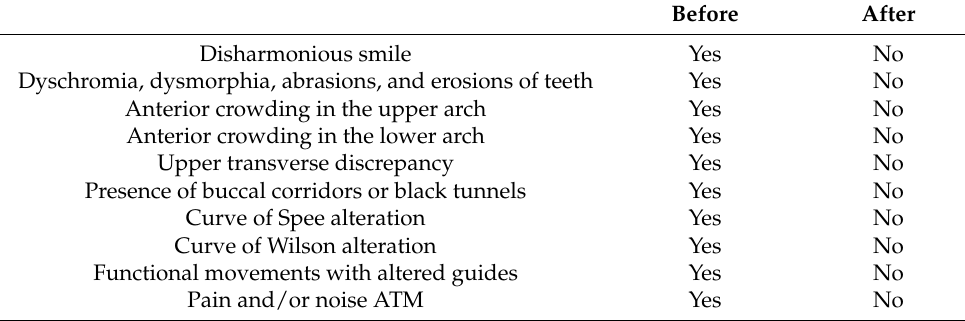
Table 1. Summary objective examination of the patient before and after treatment.